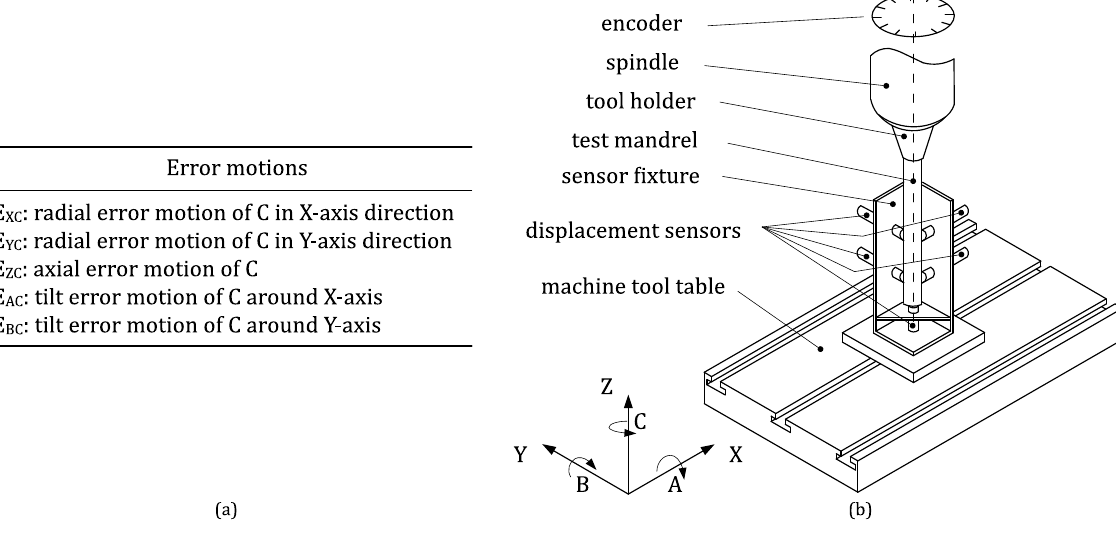
Figure 1. In accordance with ISO 230-7 [4]: ( a ) error motions of a vertical spindle C being nominally parallel to the vertical Z-axis; and ( b ) spindle measurement